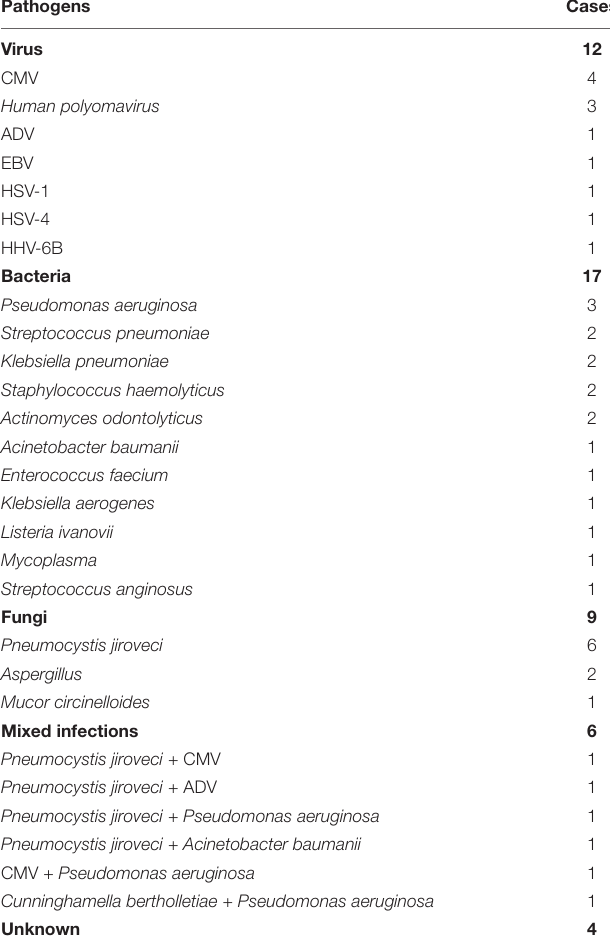
TABLE 2 | The spectrum of pathogens in pulmonary infections by mNGS ( n =